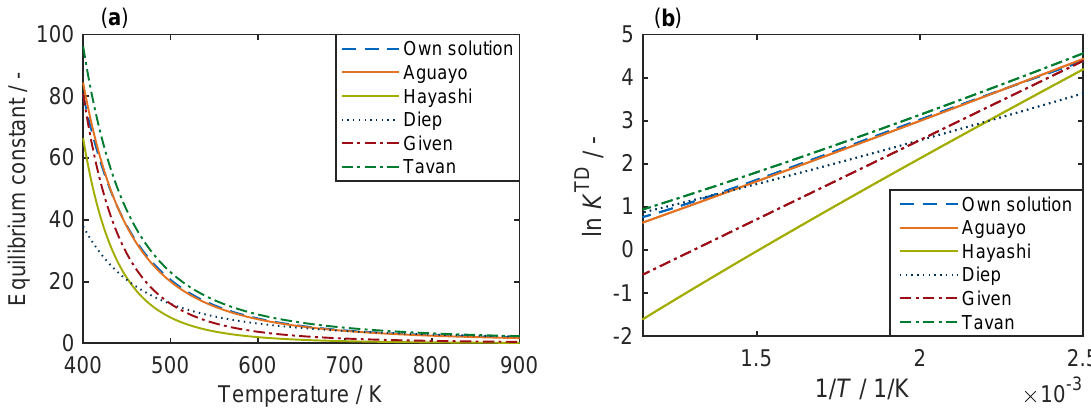
Figure 3. Equilibrium constants for the system methanol/DME/water, taken from different references [109–113] and compared with our own solution according to Figure 1, as a function of temperature: ( a ) with a regular scale; and ( b ) with a logarithmic